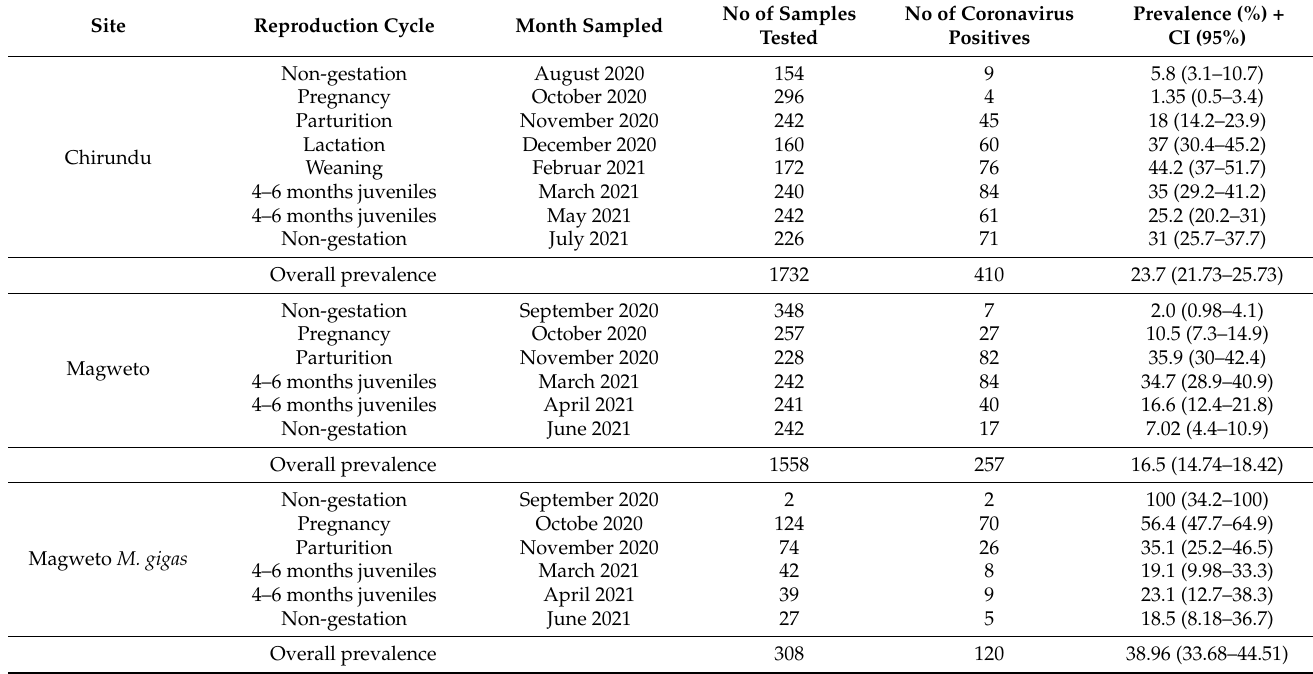
Table 1. Prevalence of CoVs and confidence intervals (CIs) per month at both sites in fecal samples from insectivorous bat